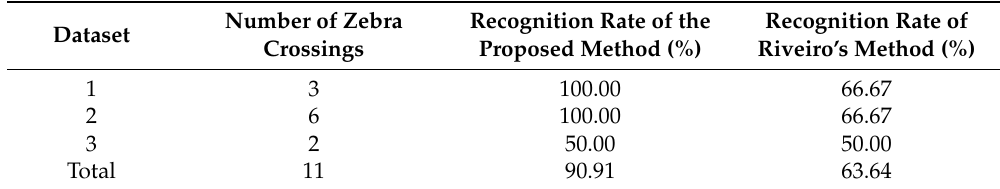
Table 3. Recognition results of zebra crossings.